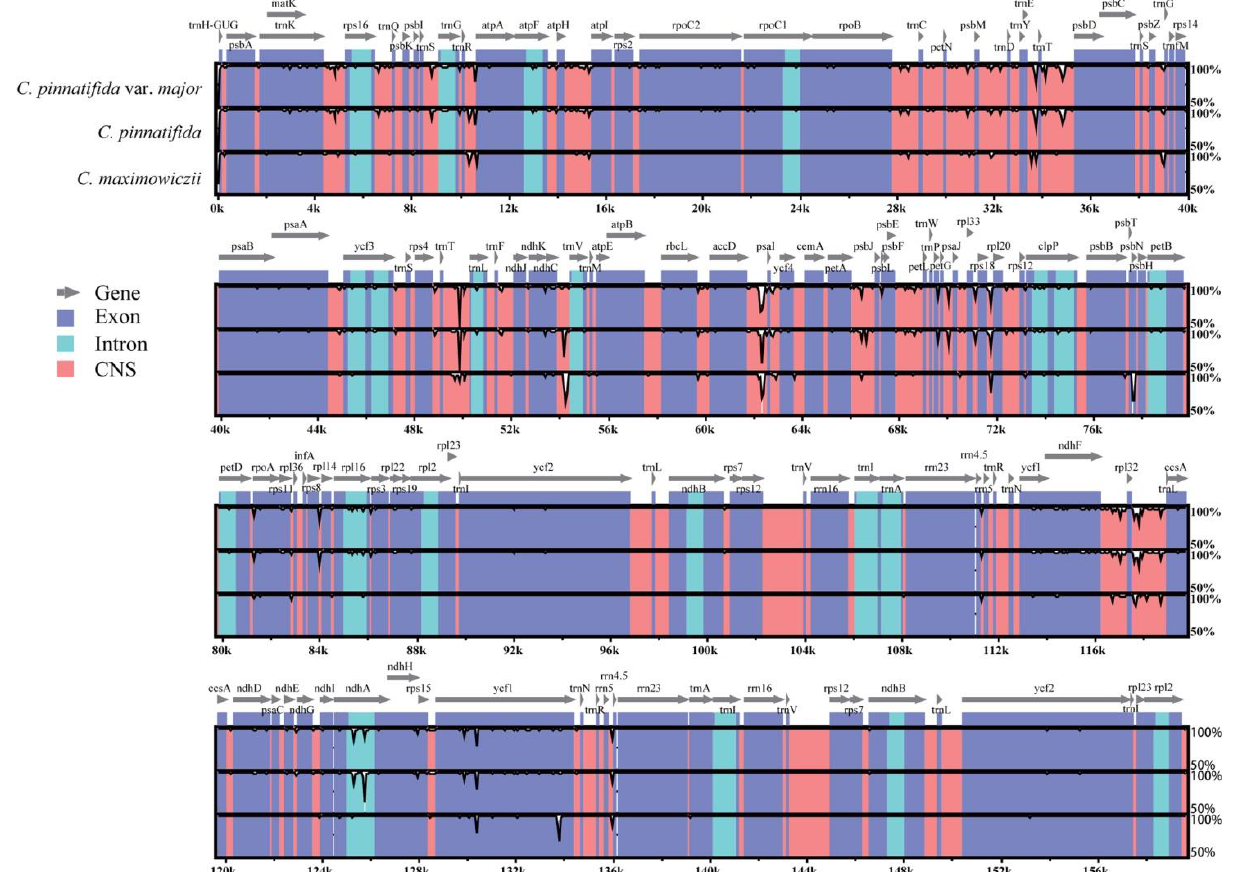
Figure 3. Sequence alignment of the four Crataegus chloroplast genomes in the mVISTA program. C. bretschneideri was employed as a reference. The x -axis indicates coordinates in the chloroplast genome. The vertical axis represents sequence alignment similarity of 50 – 100%. Gray arrow indicates gene orientation. Purple indicates exons, blue indicates introns, and pink indicates conserved non-coding sequences (CNSs).